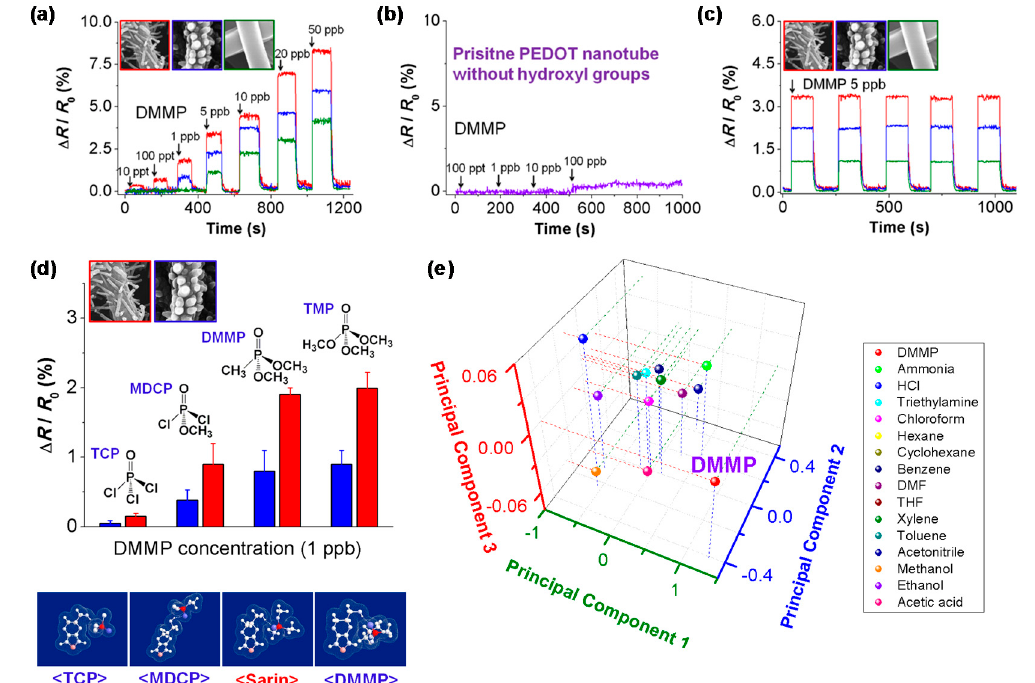
Figure 8. Dynamic sensing performance of HPEDOT nanotubes toward DMMP gas (inset; SEM images of prepared nanotubes with diverse morphologies in real time. ( a ) Sequential exposure to different DMMP gas concentrations (10 ppt to 50 ppb) in real time; ( b ) pristine PEDOT nanotube without hydroxyl groups; ( c ) periodic responses to 5 ppb DMMP; ( d ) selective response to similar organophosphorus molecules at 1 ppb (trichlorophosphate, TCP; methyl dichlorophosphate, MDCP; DMMP; trimethyl phosphate, TMP); ( e ) principal component analysis plots of the 16 vapors at 4 ppm. Reprinted with permission from [71]. Copyright 2012, American Chemical Society.